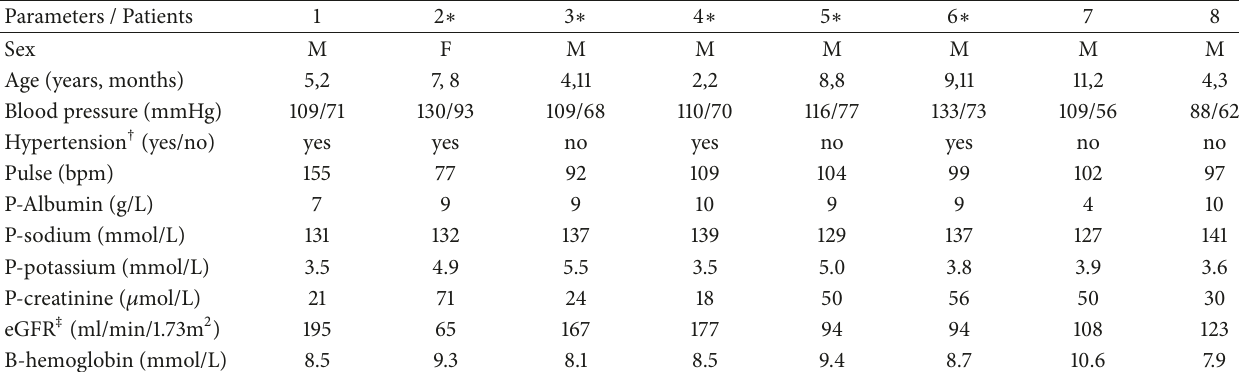
Table 3: Clinical data for the ANS